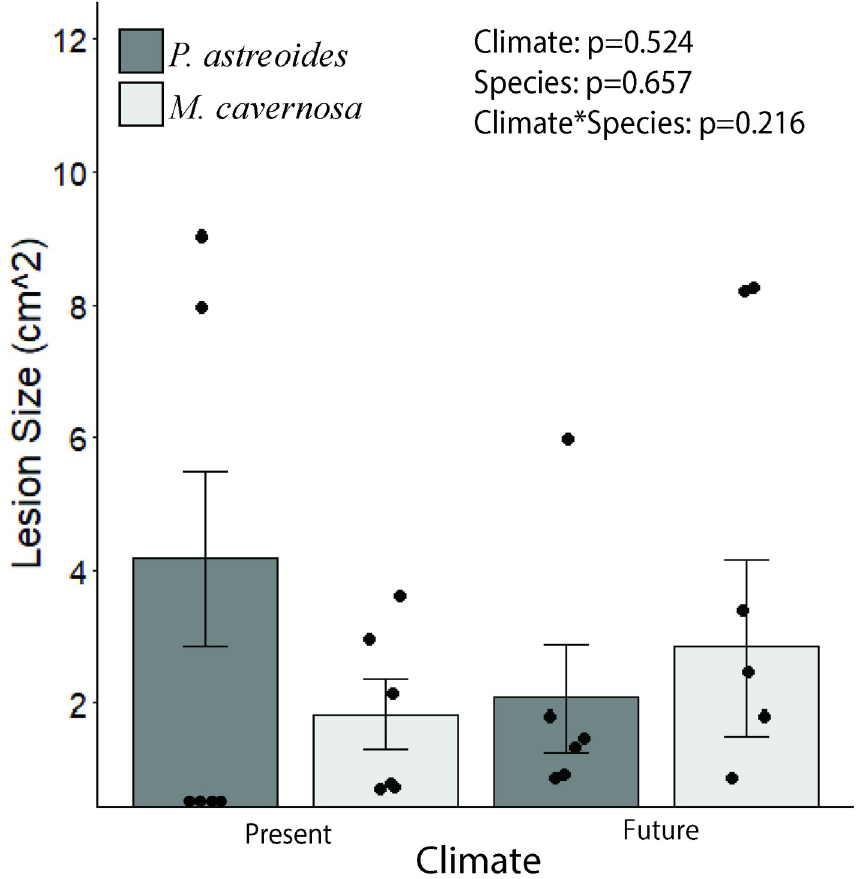
Fig 2. Lesion size (means ± SE) for Porites astreoides and Montastraea cavernosa at Day 7. Only corals in direct contact were included in the analysis. Evaluated via a two-way permutational ANOVA comparing climate and species. Dots represent individual data points. N =